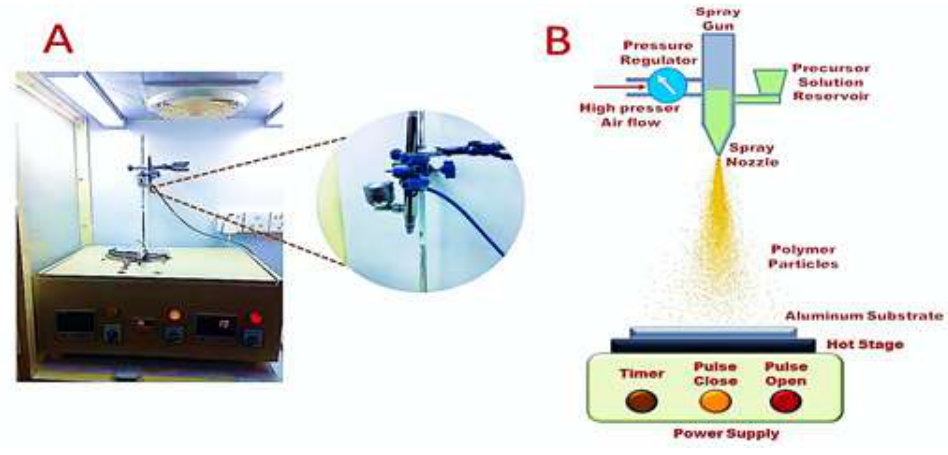
Figure 1: (A) Spray Pyrolysis device, (B) Device Diagram.